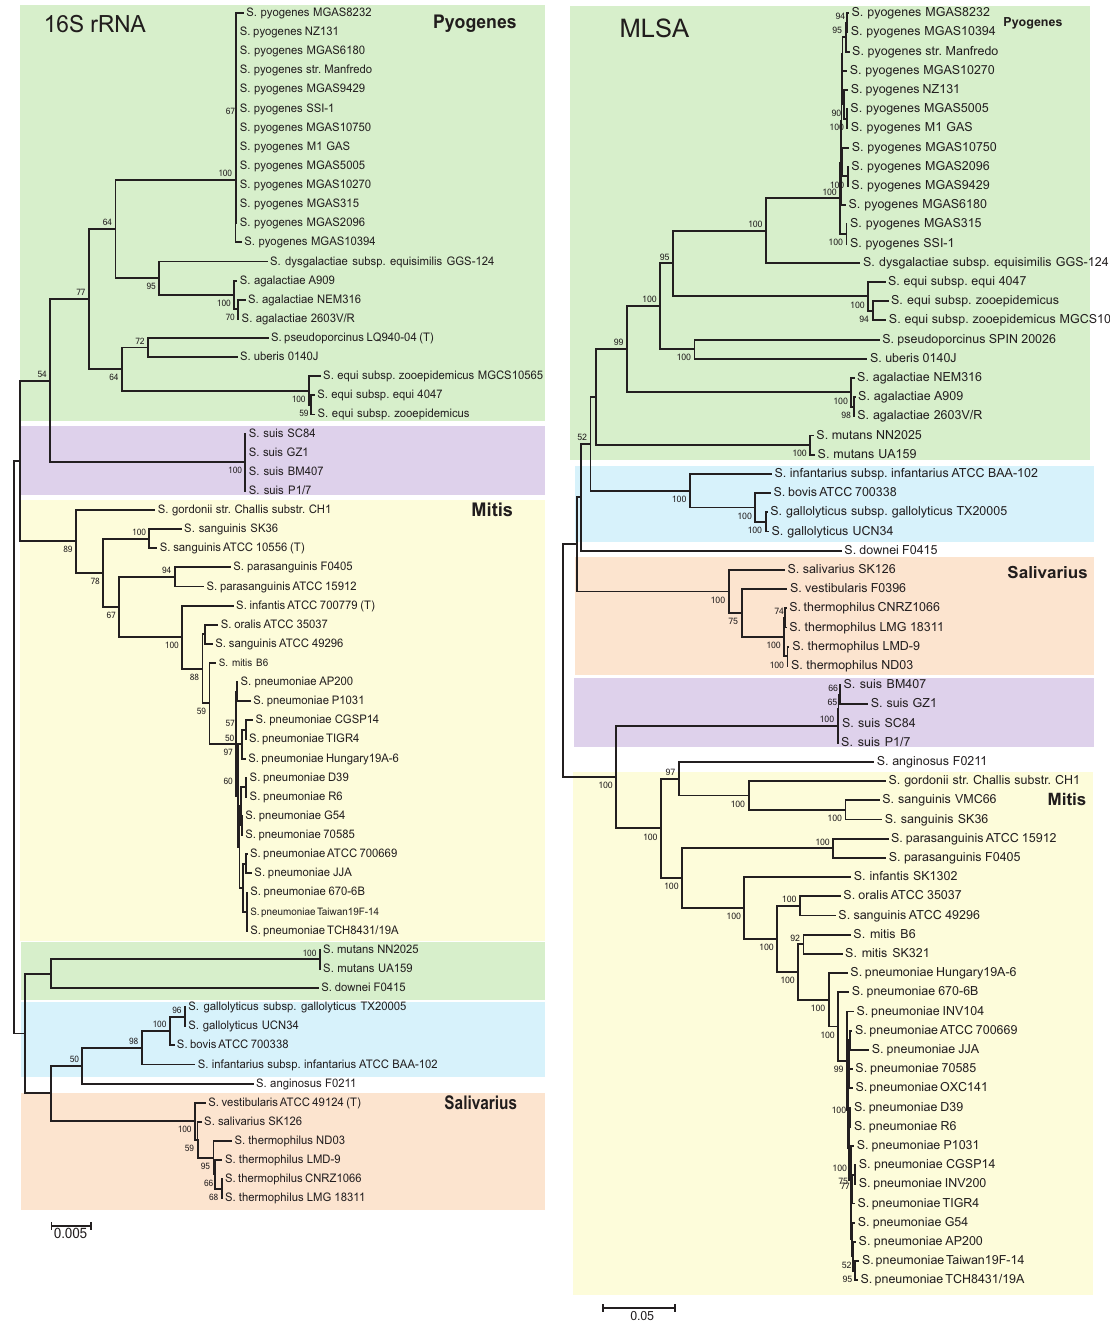
Figure 1. Neighbor-joining tree based on 16S rRNA gene sequences and MLSA concatenated sequences of Streptococcus. The numbers at the nodes indicate the values of bootstrap statistics after 2000 replications, and values below 50% are not shown. Bars, 0.005% and 0.02% estimated sequence